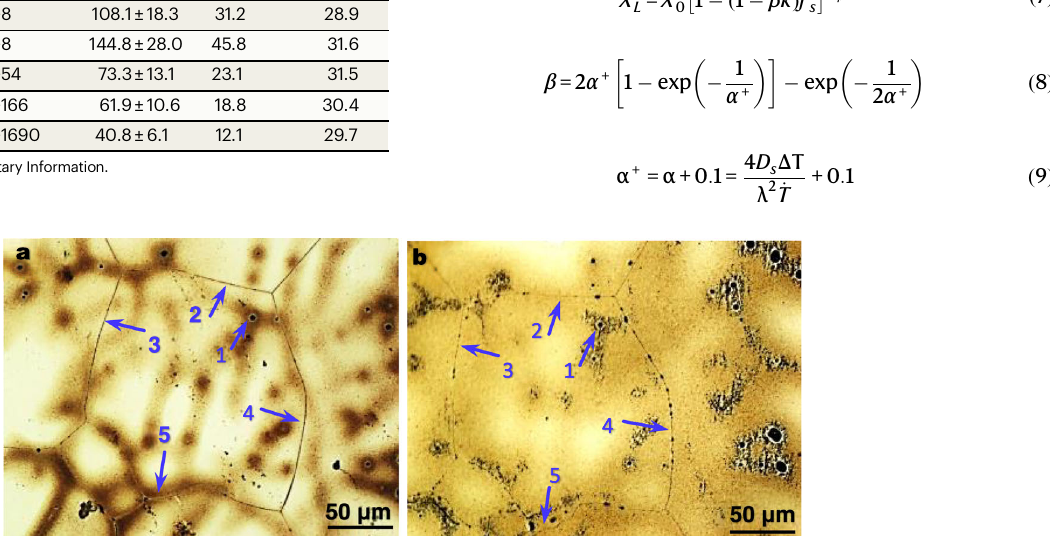
migration. b After annealing at 350°C or 0.7T solidus for 48h. No further migration was observed of the already migrated four SGBs (arrows 2 – 4), indicative of their high thermal stability. In contrast, the non-migrated curved SGB (arrow 5 in a ) displayed clear migration during this annealing